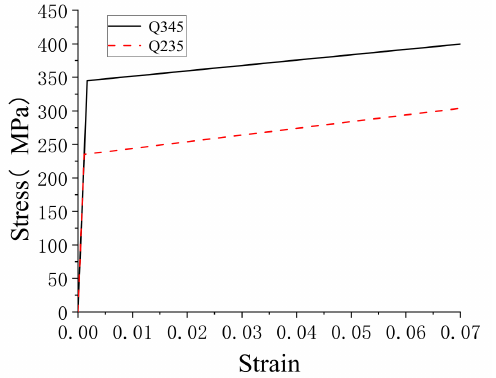
Figure 1. The stress-strain relationship for angles in the FEM